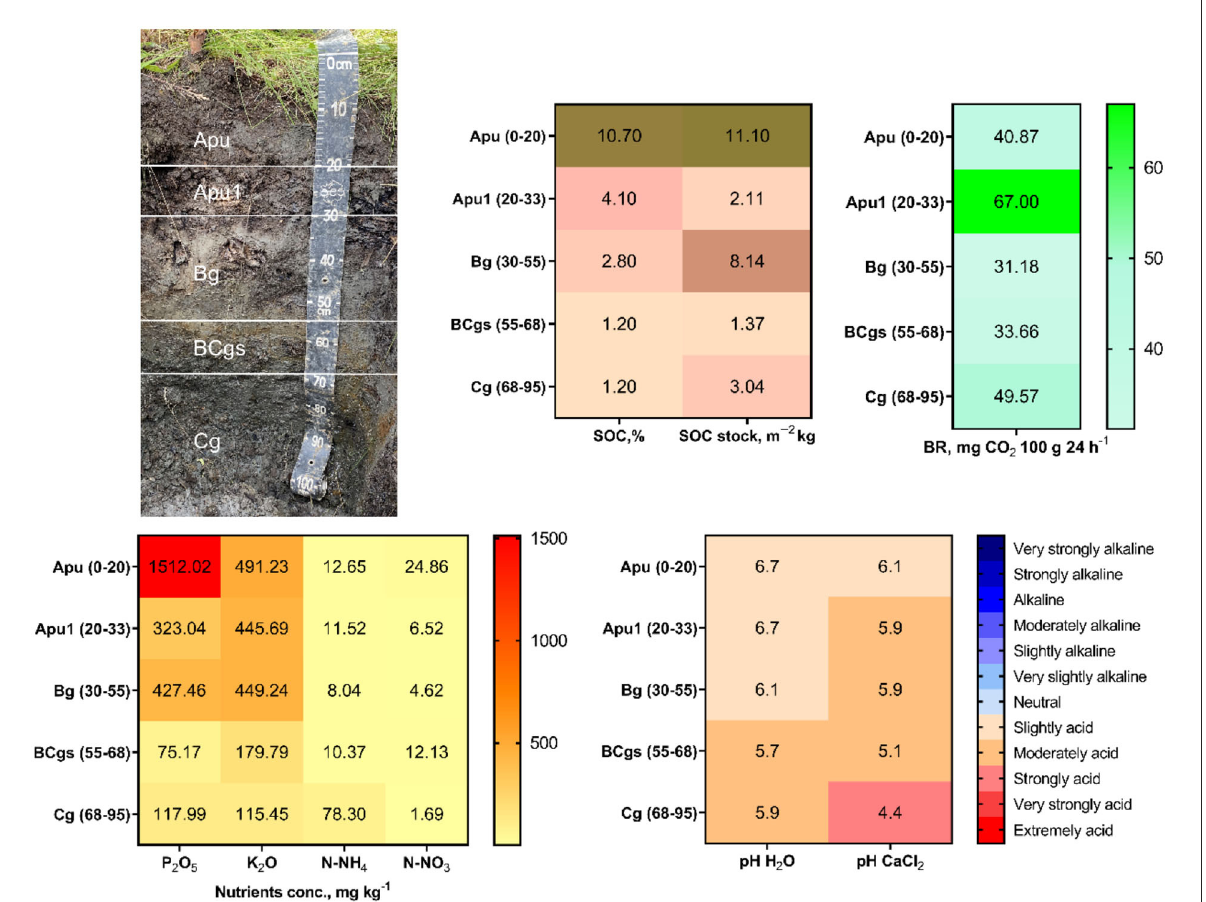
FIGURE7 Main soil properties in the abandoned vegetable garden. Soil name: Plaggic Gleyic Anthrosol (WRB,